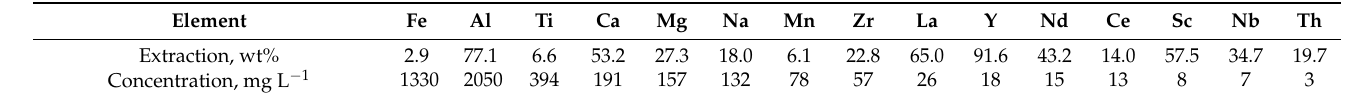
Table 4. The extraction efficiency and selected elements composition of the solution obtained after